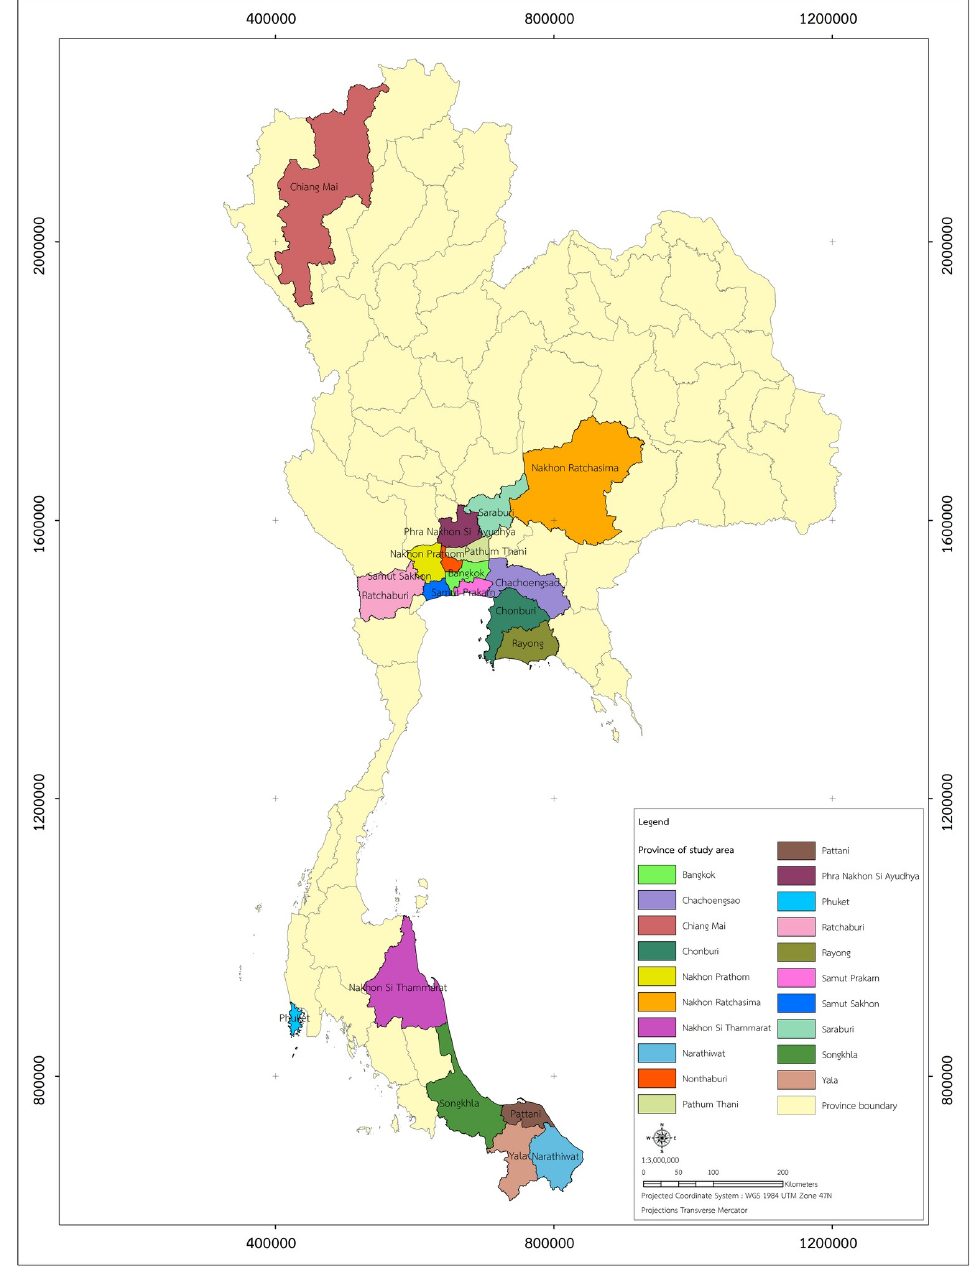
Figure 1. Location of twenty provinces with the highest cases of COVID-19 infections in Thailand, 2022.